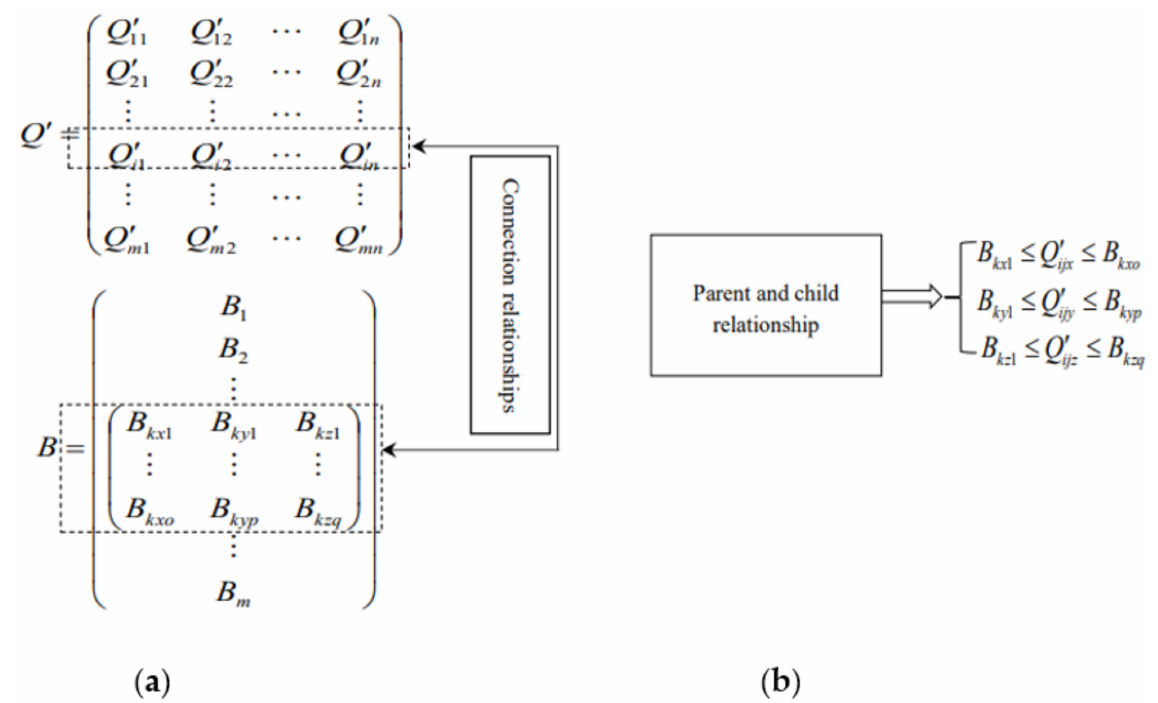
Figure 6. ( a ) The connection relationship between structural component (i) and structural component ( k ); ( b ) The parent and child relationship between matrix Q ij and